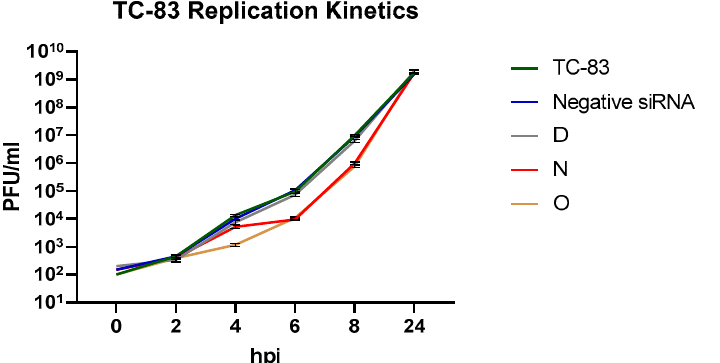
Figure 2. Twenty-four hours prior to infection, 293T cells were transfected with 20 nM anti-VEEV siRNA D, N, O and negative siRNA. Cells were infected with TC-83 at MOI 0.1 and supernatants were collected at 0, 2, 4, 6, 8 and 24 hpi. Viral titer was determined via plaque assay. Graphs represent data from two independent experiments ( n = 6).